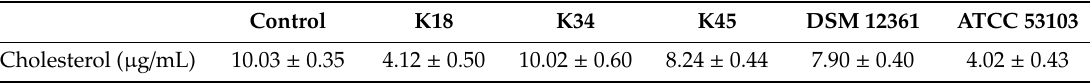
Table 6. Cholesterol amounts recovered in cell-free supernatants from broth cultures (in MRS) inoculated with A. kunkeei K18, K34, K45 and DSM 12361 and L. rhamnosus GG ATCC 53103 and analyzed